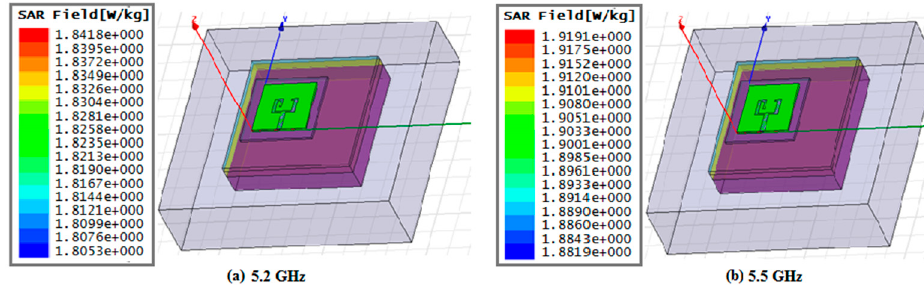
Figure 15. Simulated specific absorption rate (SAR) pattern at 5.2 GHz and 5.5 GHz.